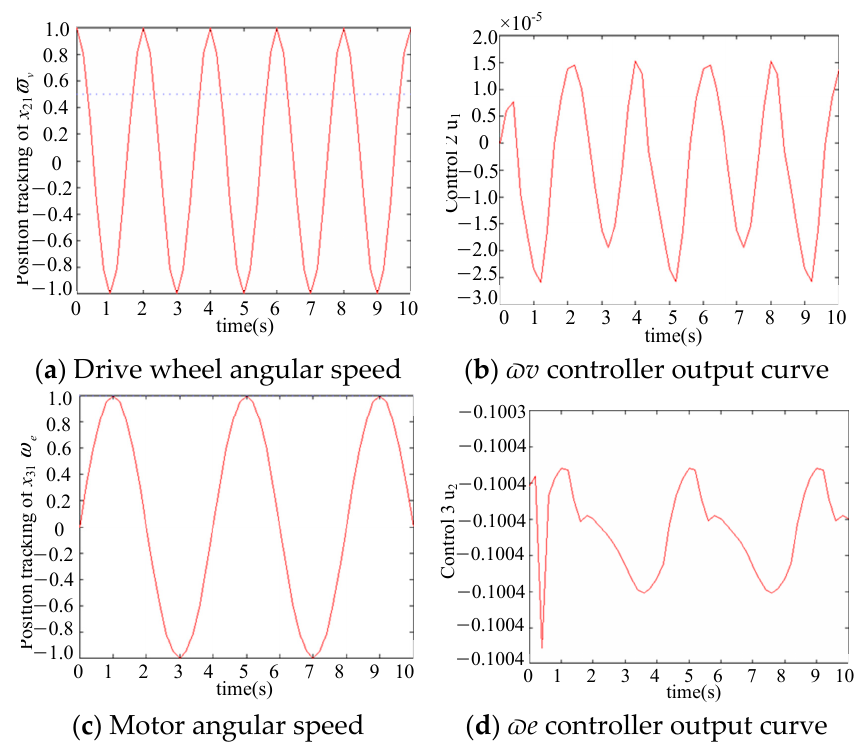
Figure 4. Output of the system state control function simulation. After stabilization, the simulation result of the control output u 1 for the drive wheel angular velocity x 2 is floating, but the range of the floating value is − 2.5 × 10 − 5 to 1.5 × 10 − 5 . The simulation result of the control input u 2 for the motor angular velocity x 3 is also floating, but the floating value is always approximately − 1.004. Thus, convergence and chattering are considered to have been eliminated. Make the system’s position instruction relative rotation x 11 d = 1, drive wheel angular speed x 21 d = 0.5 cos π t , and motor angular speed x 31 d = t . Continuous functions are used to reduce chattering. δ 0 = 0.03 and δ 1 = 5. The simulation results are shown in Figure